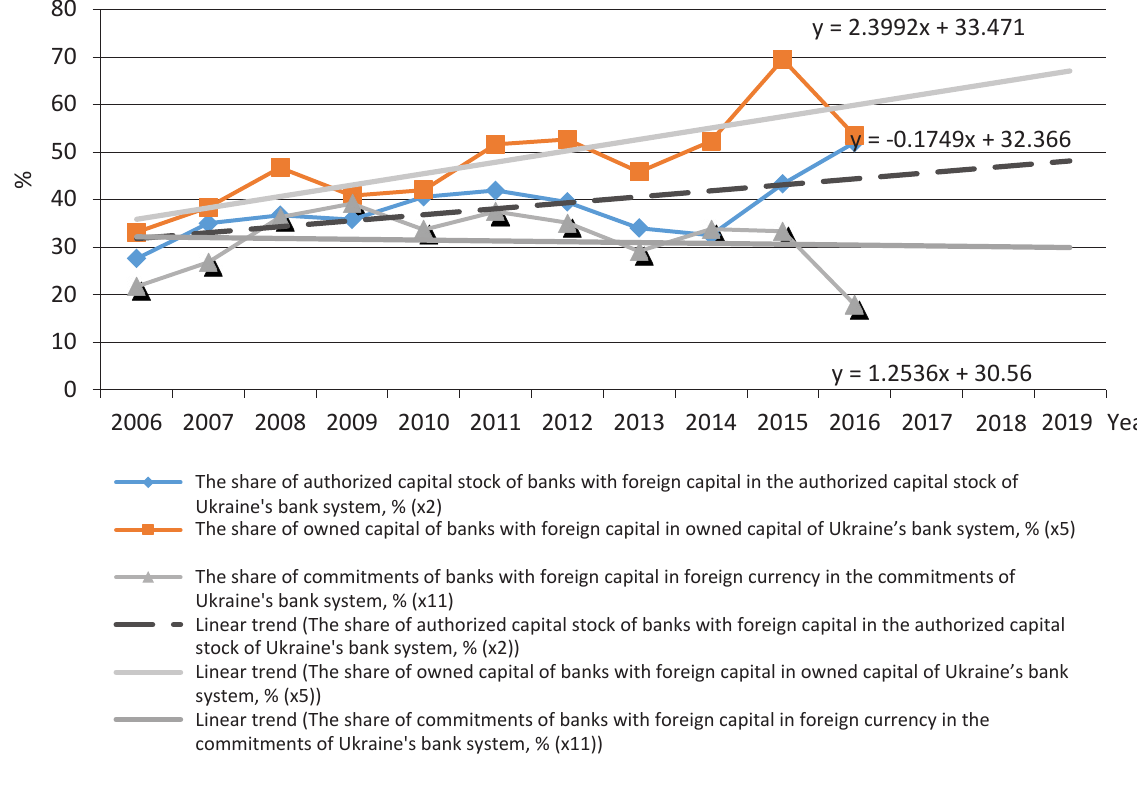
Figure 2. Trend analysis of foreign banks capital and commitments via construction of diagram reflecting the linear trend